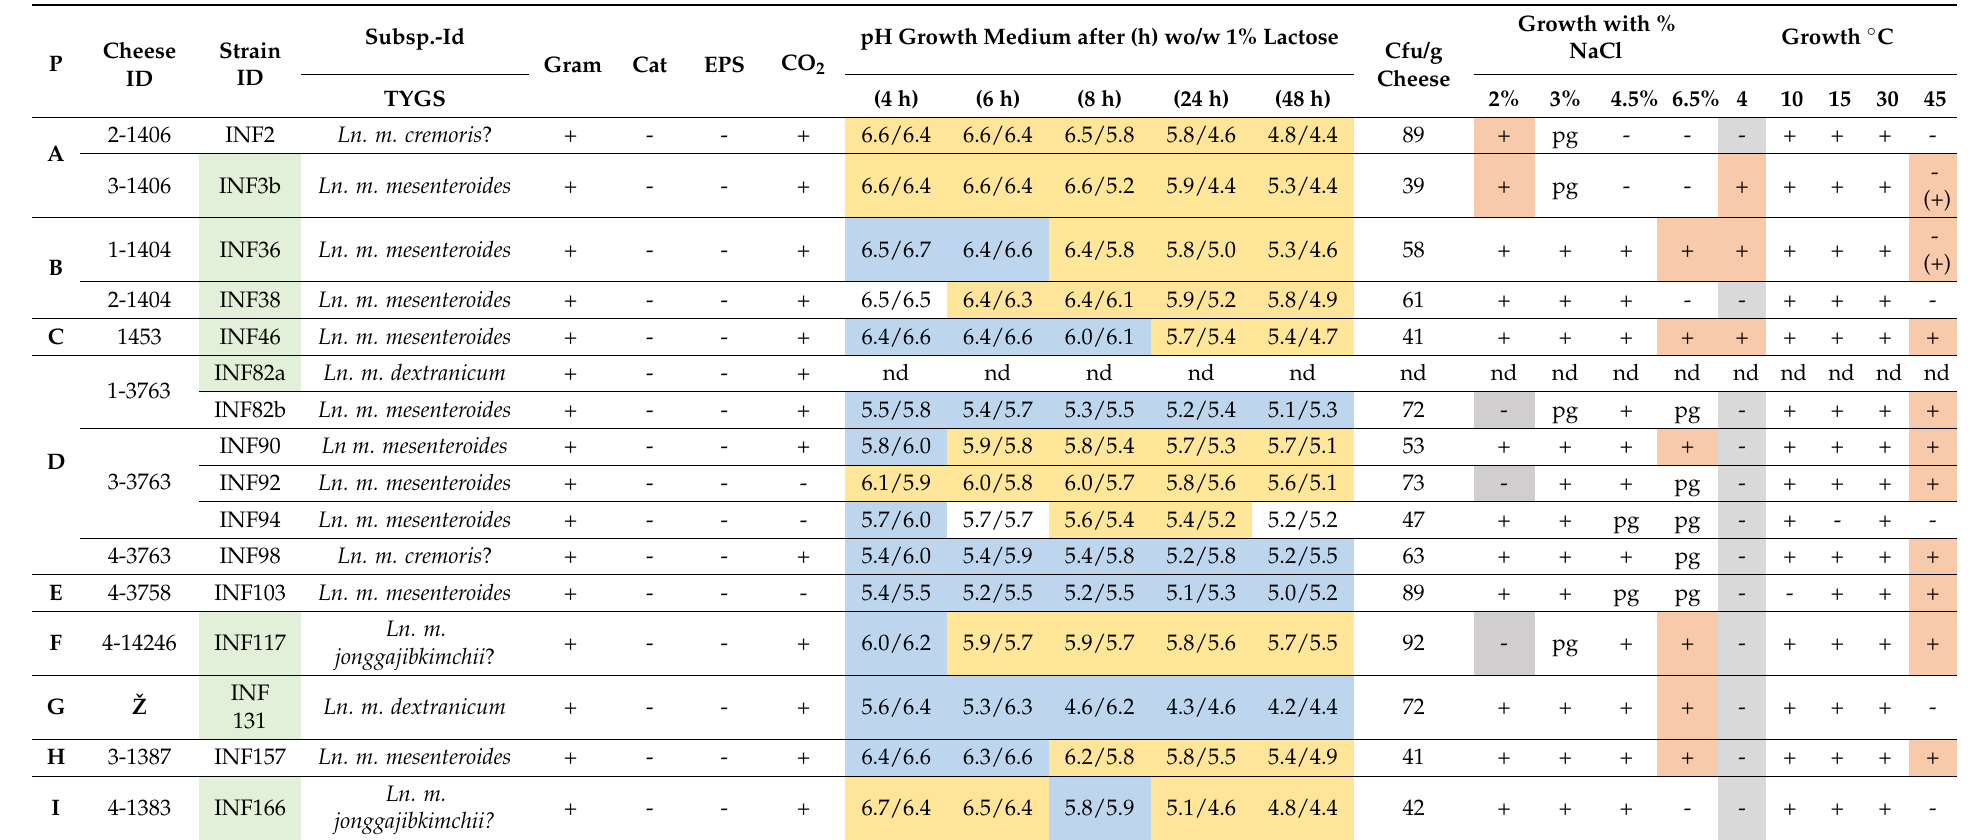
Table 1. Data on origin, subspecies, growth, and biochemical parameters of the investigated Ln. mesenteroides strains. (nd) not done, (pg) poor growth, (cfu) colony forming units, (P) producer, (Cat) catalase ( ) pH decrease wo/w 1% lactose, ( ) pH increase wo/w 1% lactose, ( ) cit operon positive strains, ( ) no growth in minimum conditions, ( ) growth in minimum and/or maximum conditions.